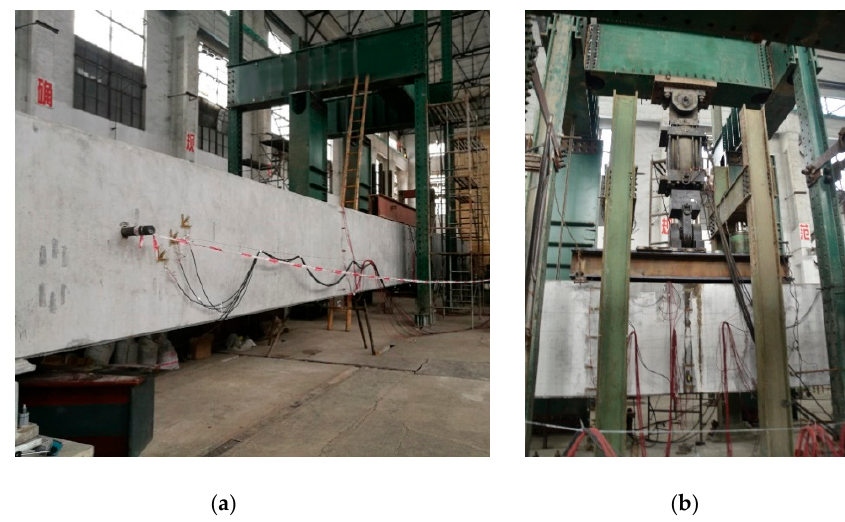
Figure 5. Loading setup: ( a ) specimen and device; ( b ) detail of Material Testing System (MTS) electrohydraulic servo actuator.